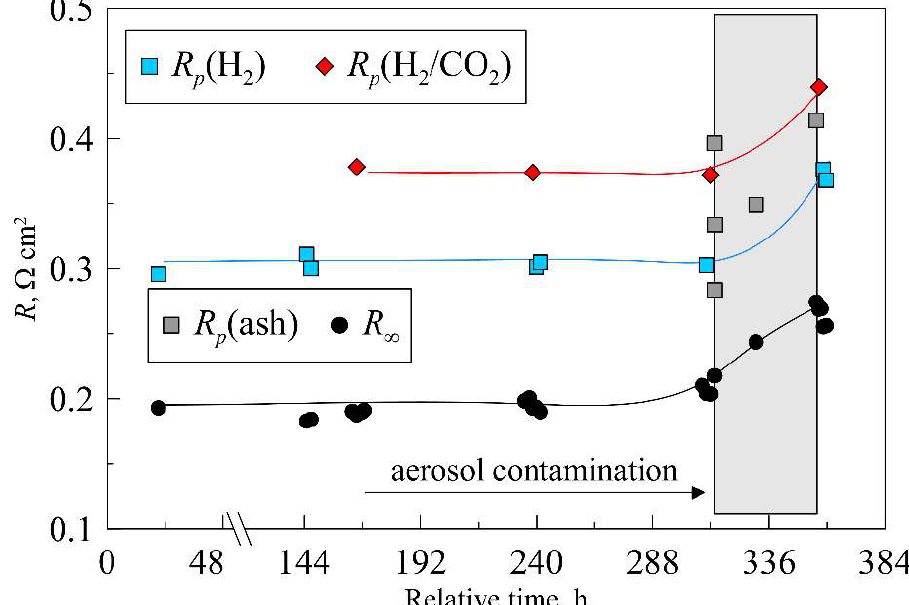
Figure 11. Impact of aerosol application on SOFC performance. Lines are for visual guidance only. R p (H 2 ): polarization resistance in fuels containing 80% and 50% H 2 in N 2 ; R p (H 2 /CO 2 ): polarization of the cell in 20% H 2 in CO 2 fuel; R p (ash): polarization resistance for H 2 /CO 2 fuel contaminated with fly ash (see text for details); R ∞ : ohmic resistance of the cell.